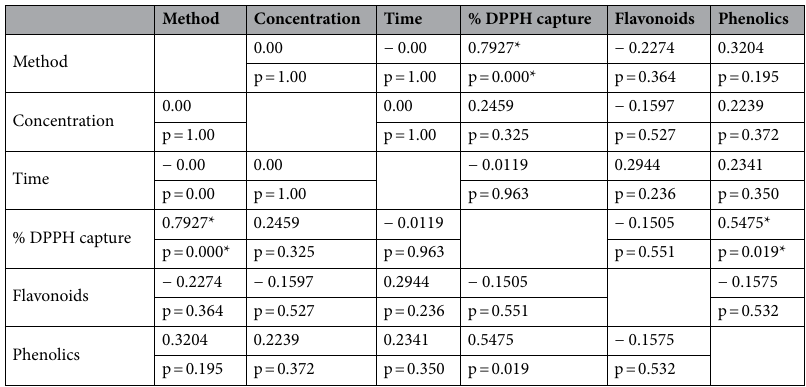
Table 6. Pearson correlation for methanol extract. *Results statistically